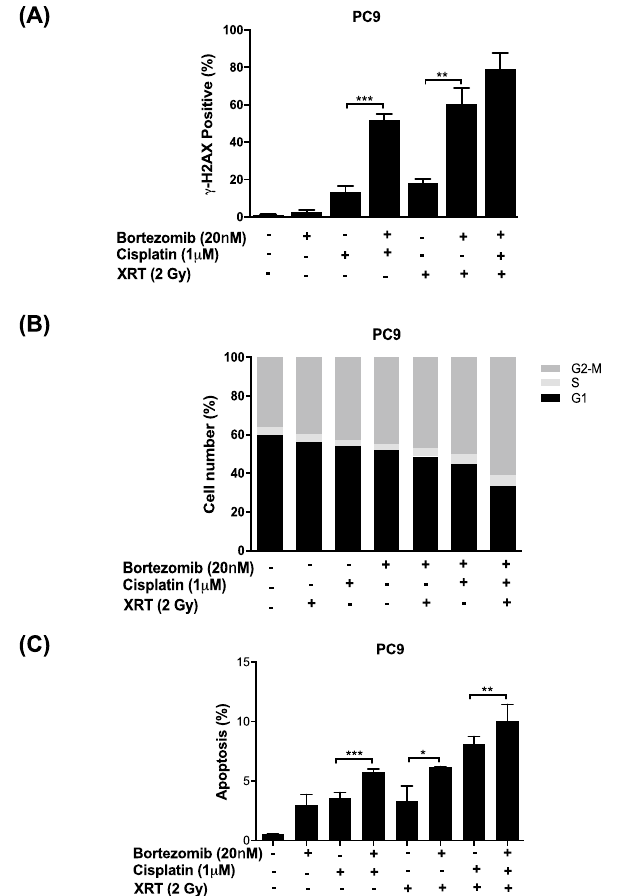
Figure 3. Combined treatment with bortezomib, cisplatin and radiation results in enhanced DNA damage, cell cycle arrest and enhanced apoptosis in NSCLC cells. Smurf2 inhibition with bortezomib significantly enhanced DNA damage, as shown by the significantly increased percentage of γ-H2AX-positive NSCLC cells after treatment with bortezomib plus cisplatin or radiation compared to treatment with bortezomib, cisplatin, or radiation alone ( A ). In PC9 cells, combined treatment with bortezomib plus cisplatin plus radiation induced G2/M-phase arrest ( B ), which was associated with increased apoptosis ( C